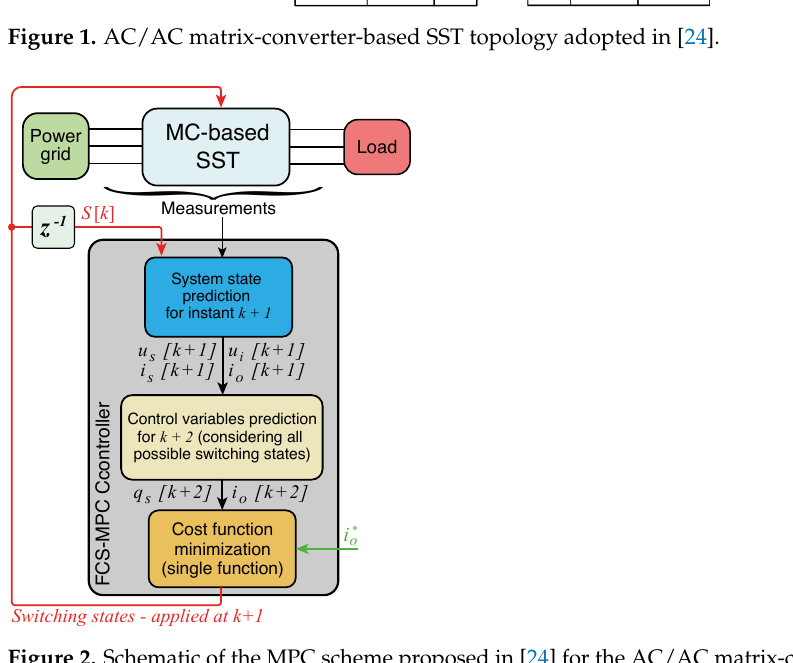
Figure 2. Schematic of the MPC scheme proposed in [24] for the AC/AC matrix-converter-based